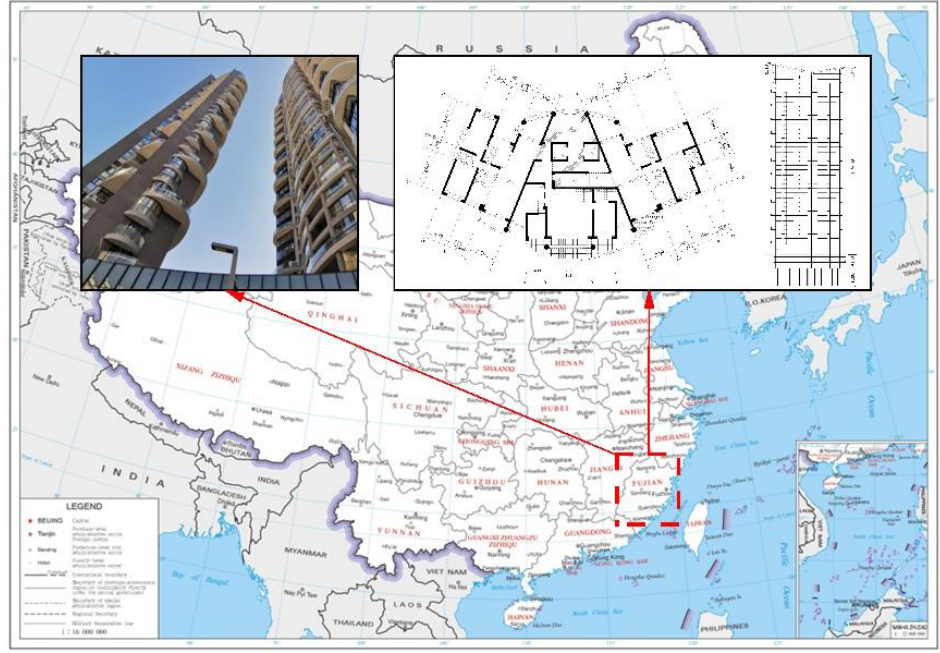
Figure 1. Project Information .